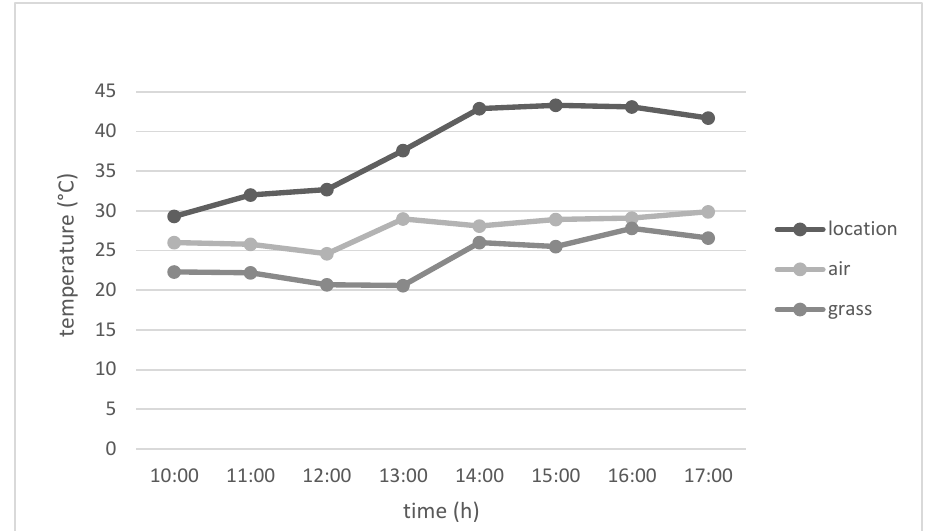
phalt mixture, 5th September 2019.